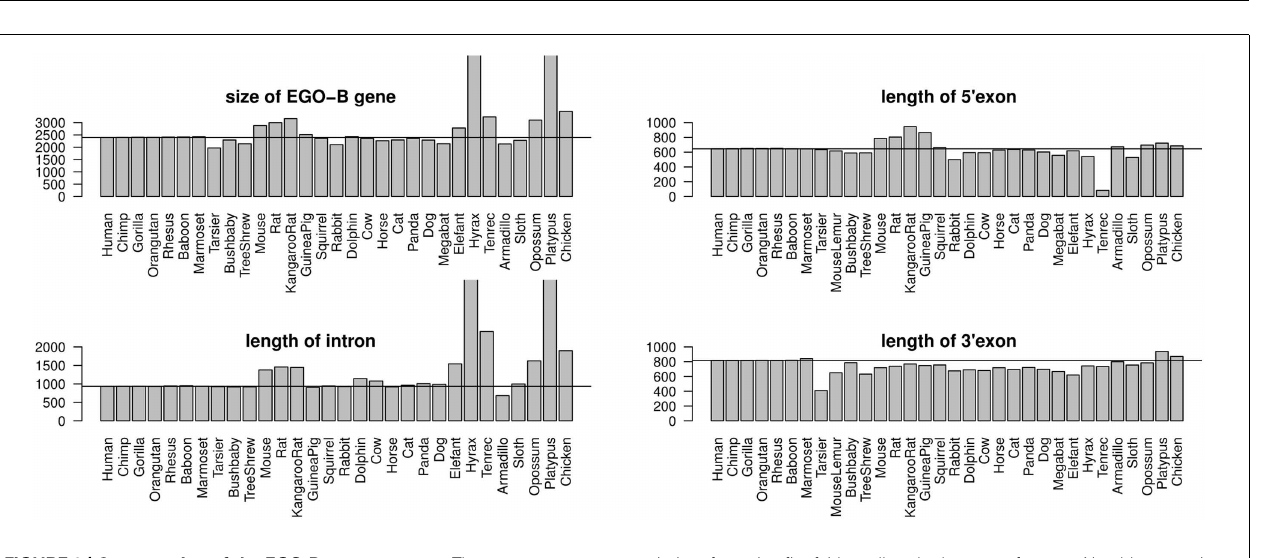
FIGURE 3 | Conservation of the EGO-B gene structure. The gene structure, in particular the exon/intron lengths of the identified EGO-B transcripts are well conserved among orthologs. Horizontal lines mark the lengths of the human reference. In summary, the gene structure of the